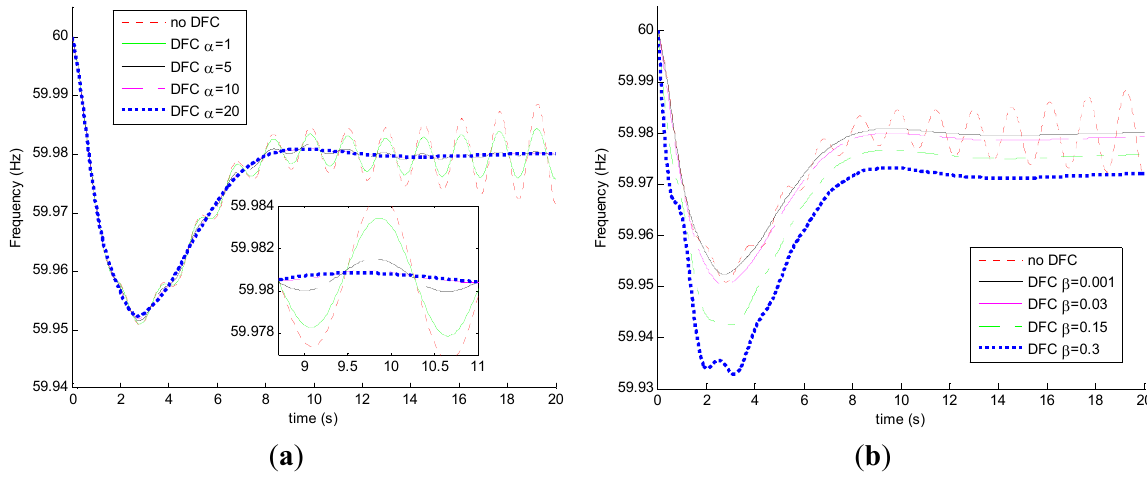
Figure 4. Comparisons of the frequency deviations under different controller parameters in a small disturbance ( a ) different α ( β = 0); ( b ) different β ( α = 20).